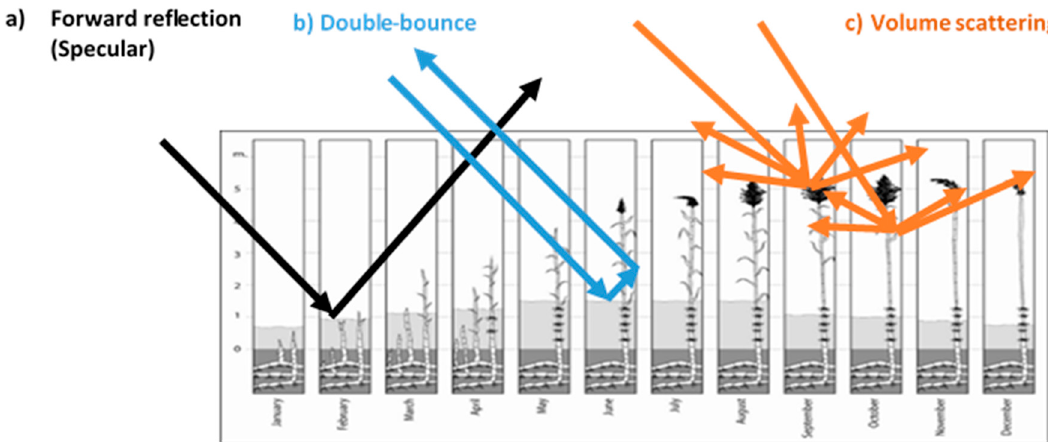
Figure 1. Phenological calendar of reed in the Danube Delta; schematic representation of scattering mechanisms at C band for macrophytes vegetation Phragmites australis : ( a ) forward reflection (specular); ( b ) double-bounce; and ( c ) volume scattering.